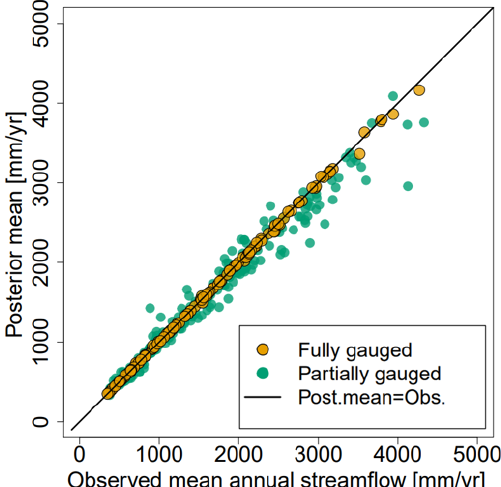
Figure 7. Scatter plot showing the predicted mean annual runoff for SVC PP and the observed mean annual runoff from fully gauged (orange) and partially gauged catchments